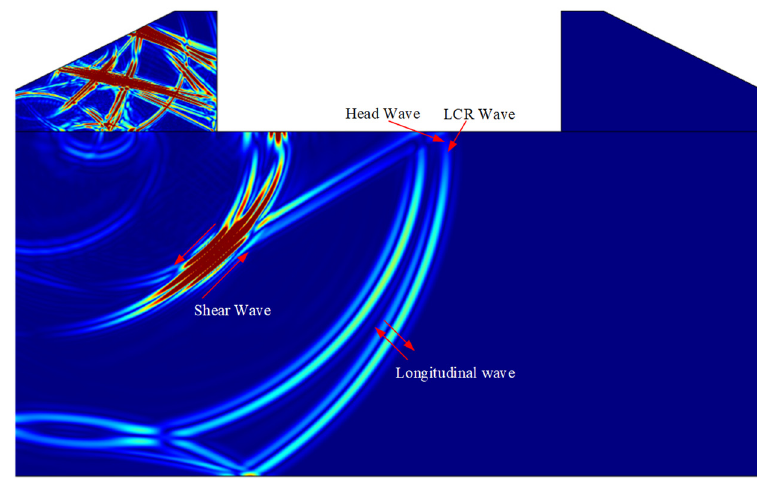
Figure 7. Longitudinal critically refracted wave propagation contour (no groove).